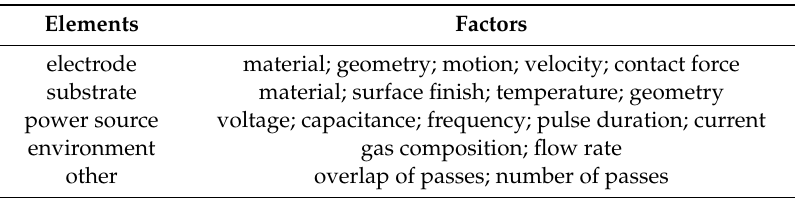
Table 1. Process variables of high energy spark